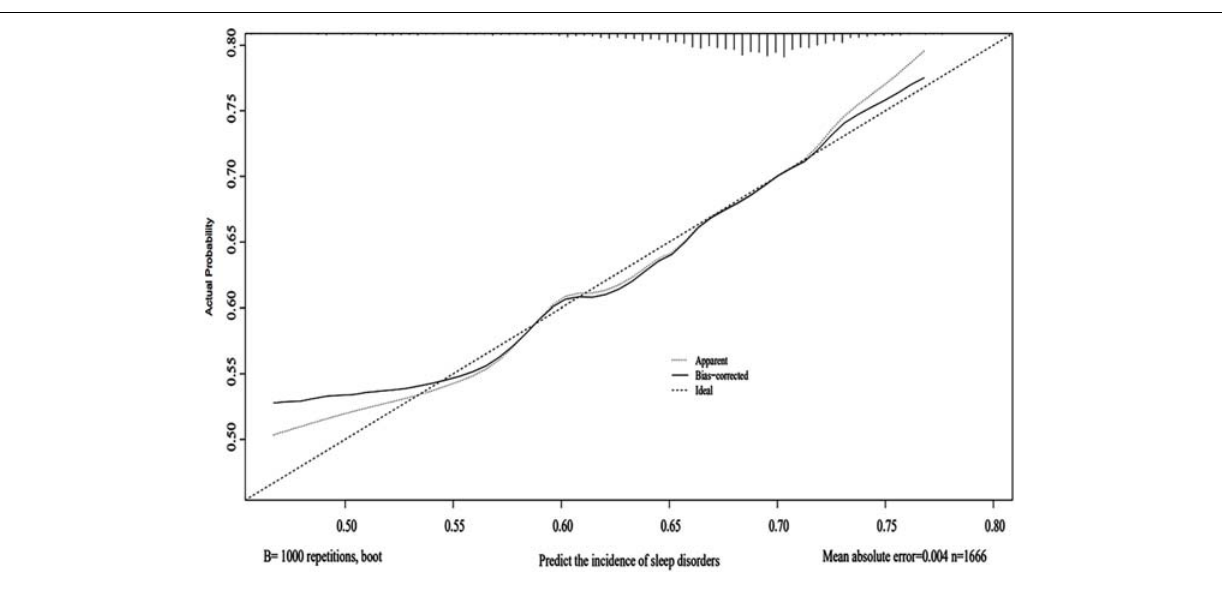
Frontiers in Neuroscience |